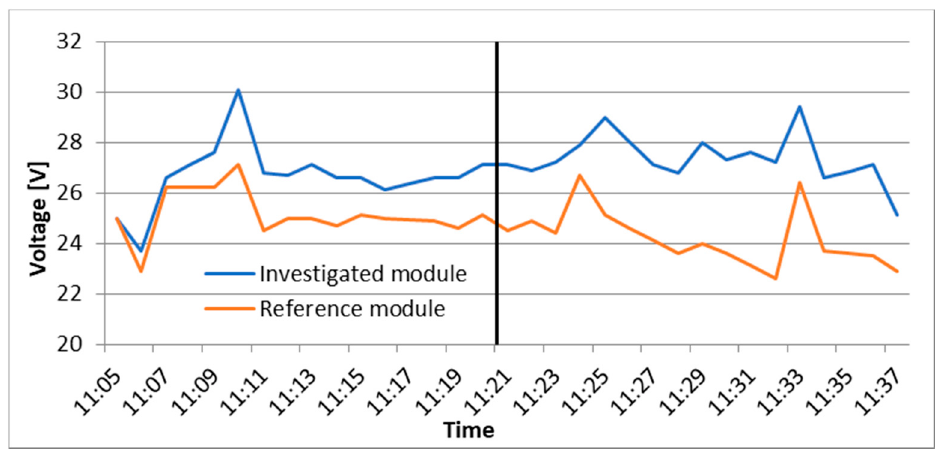
Figure 8. Voltages of investigated and reference modules during the comparative 30-min test.